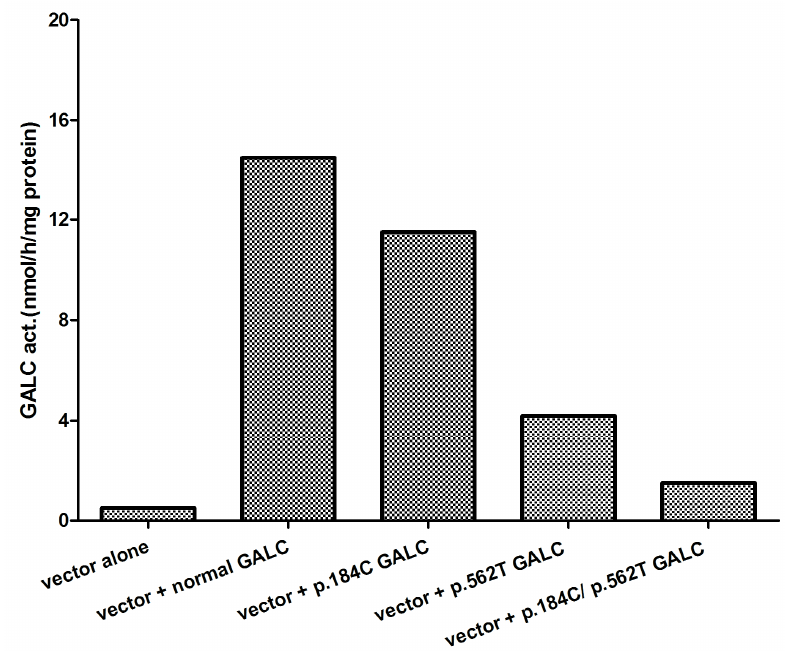
Figure 1. Cells of the common polymorphic variants found in the GALC gene. Cultured cells were transfected with plasmid containing either wild type GALC cDNA or GALC cDNA containing the two changes alone and together. After 72 h in culture, the cells were harvested, and GALC activity was measured.